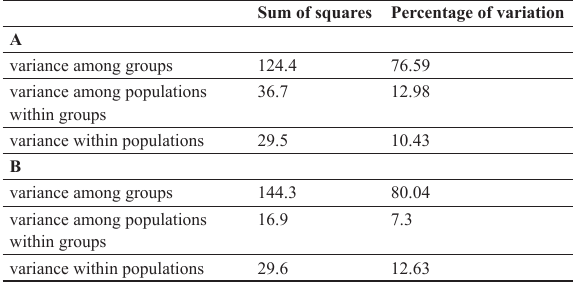
= 0.554 (p = 0.000), F SC ST = 0.766 (p = 0.01)) and B) “north- CT = 0.367 (p = 0.000), F = SC ST